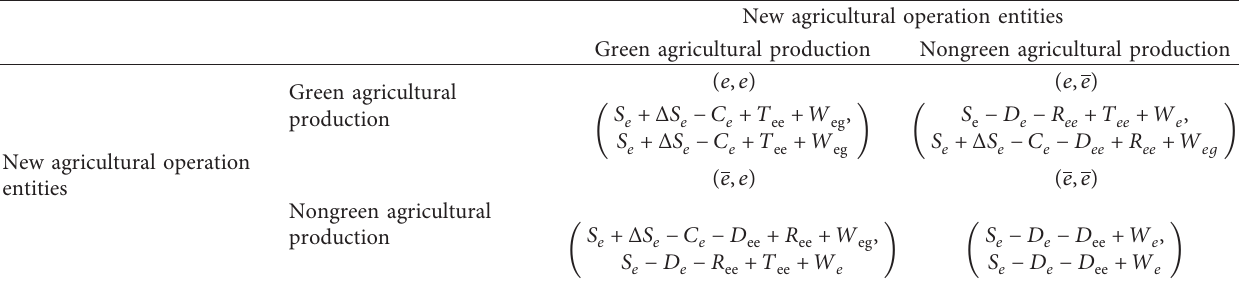
Table 6: The pairwise game matrix among new agricultural operation entities under the government guidance